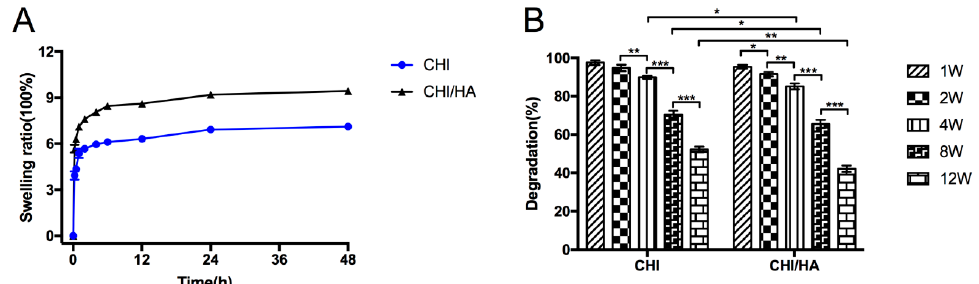
Figure 1. Swelling ratio in DMEM medium at 37 °C ( A ) and degradation in 37 °C warm PBS solution with 0.5 mg/mL lysozyme ( B ) of chitosan and chitosan with hyaluronic acid scaffolds at different time points. (* p < 0.05, ** p < 0.01, *** p <